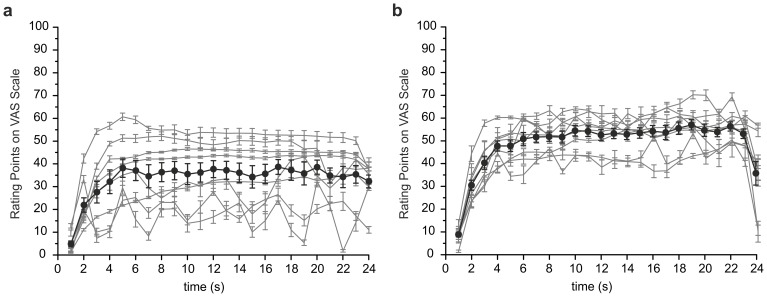
Painfulness of the stimulus.To evaluate the painfulness of DOMS all subjects rated the pain perceived during contraction or physical stimulation. Subjects contracted the thigh repeatedly during 5 cycles of 24 seconds each or the respective muscle was stimulated with the heavy marble rolling pin by the experimenter (compare protocol in Fig.
1). Individual pain-ratings (VAS-scale) are given as averages across the 5 cycles (grey lines) and as common average (black circles) across the group. On average the subjects rated the painfulness of (a) the voluntary contraction to 35±14 % and (b) the physical stimulation as 50±8 % on the VAS scale. Thus, physical stimulation was judged as more painful (n = 8 each; p = 0.02 Mann-Whitney U-test; error bars show S.E.M.; grey areas indicate averaged highs and lows). Subjects had no resting pain and experienced pain only during stimulation of the affected limb and not of the control side.